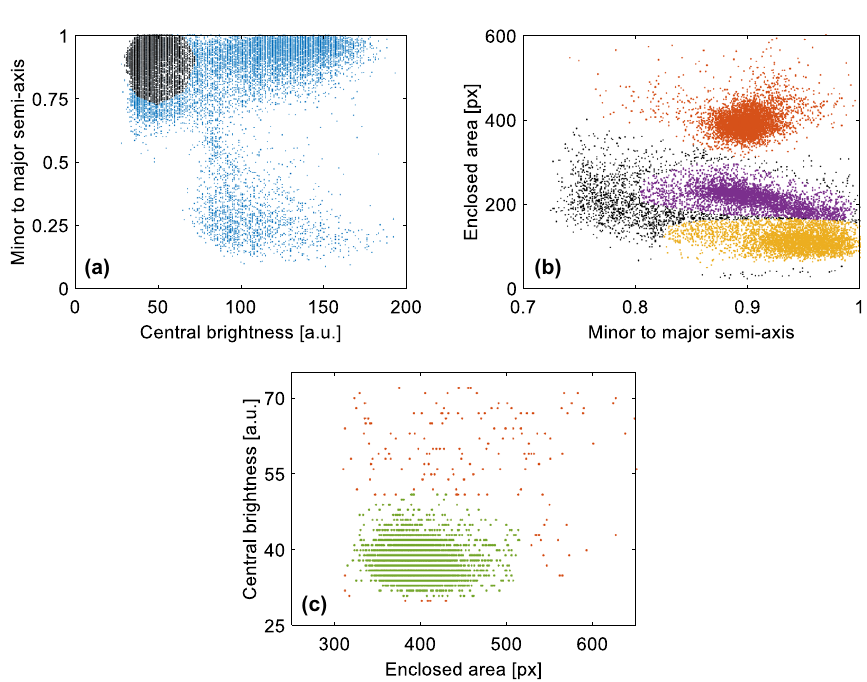
Figure 3. Illustration of the background discrimination using the raw data acquired with CR-39 track detectors. Only pits are accepted, whose ellipse parameters lie within certain boundaries, that can be attributed to ion signal. In total, three filtering stages have been applied to the CR-39 data. The accepted data points in ( a ) are drawn in black. In ( b ), the ion species can be separated by their pit sizes: orange refers to gold ions, violet to oxygens and yellow to carbons. ( c ) The last filtering step for the example of gold ions. The accepted data points are displayed in green. The two-dimensional gate conditions in each step have been defined by hand. The selected regions around the parameter correlations were chosen as small as possible in order to exclude a maximum number of background data points, but large enough that no correlated patterns related to the observed ion curves - especially for heavy ions—appeared in the discarded